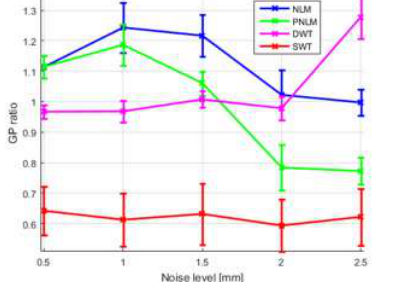
Figure 4. Comparing performance of the four denoising methods on the noisy grids of 5 mm.